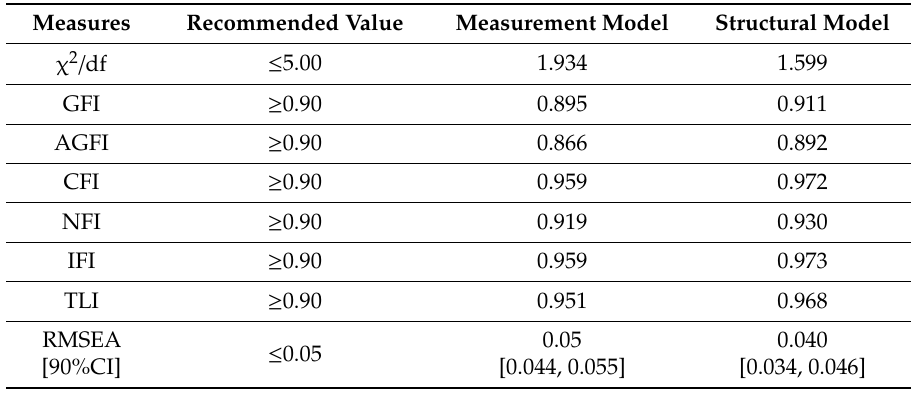
Table 4. Evaluation of model goodness-of-fit.